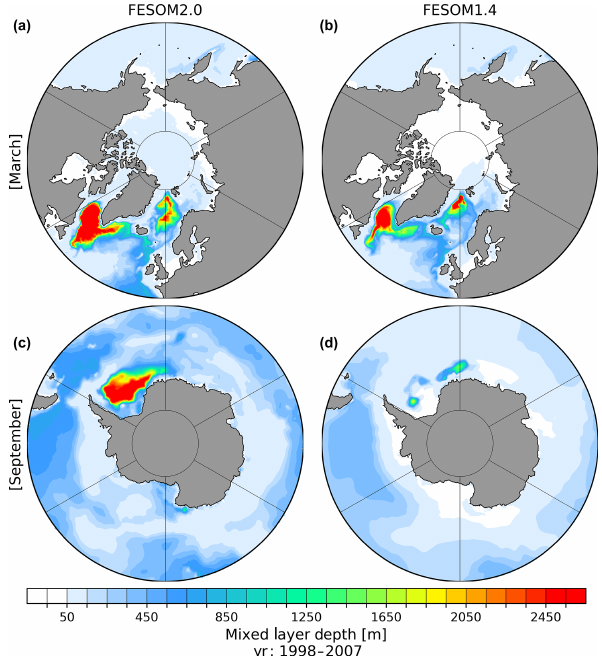
Figure 16. March (a, b) and September (c, d) MLD (definition after Monterey and Levitus, 1997) averaged over the period of 1998– 2007 of FESOM2.0 ( a, c , GM, Redi and KPP) and FESOM1.4 ( b, d , GM, Redi and KPP) reference